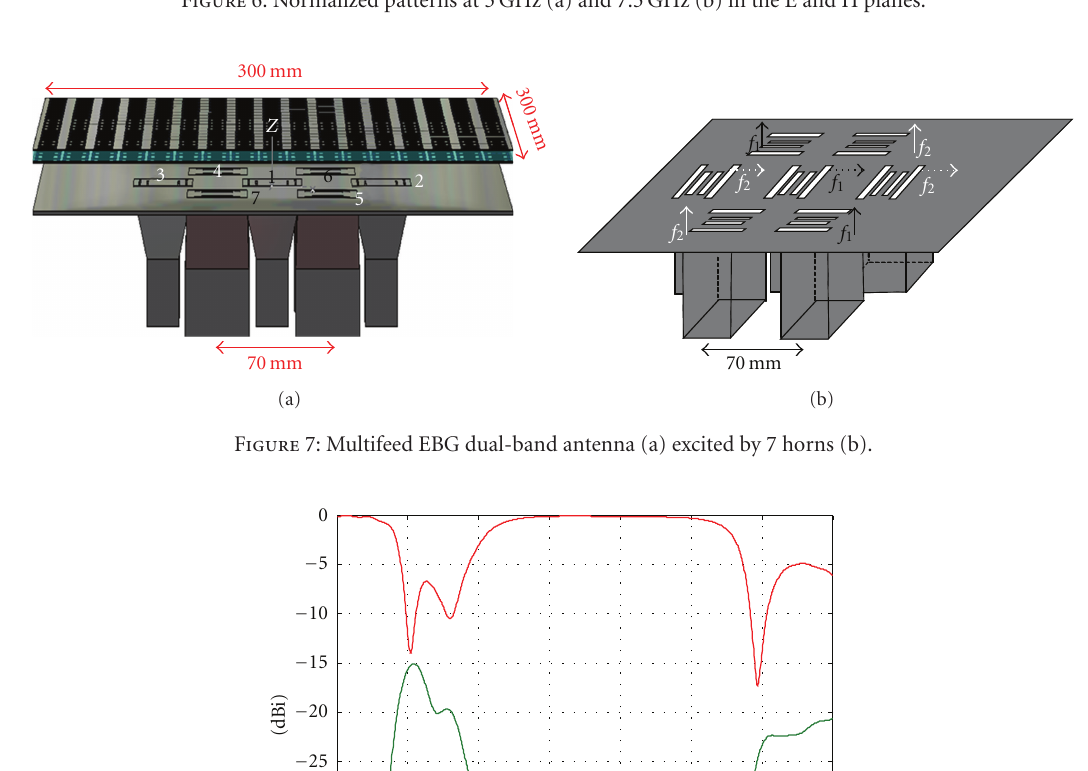
Figure 6: Normalized patterns at 5 GHz (a) and 7.5 GHz (b) in the E and H planes.